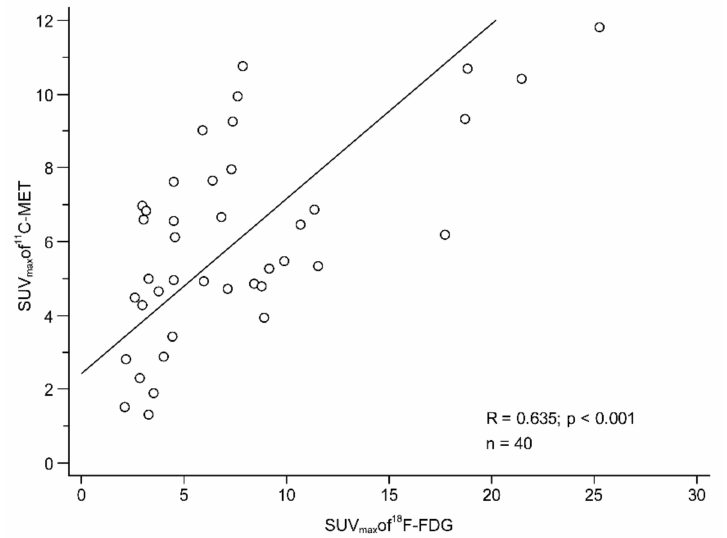
Figure 3. Correlation between F-18 FDG and C-11 MET uptake in RCC. There was a moderate correlation between the SUV max of F-18 FDG and C-11 MET PET/CT (r = 0.63, p < 0.001). RCC, renal cell carcinoma; FDG, fluorodeoxyglucose; MET, methionine; SUV max , maximum standardised uptake value.